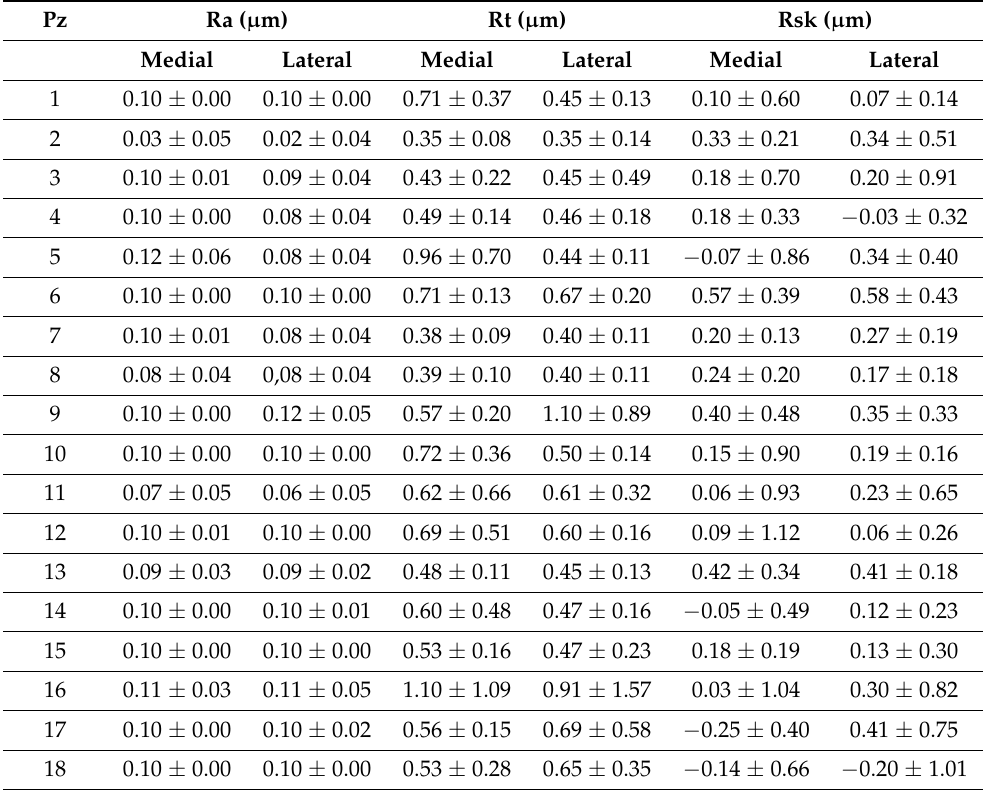
Table 2. Roughness measurements on the femoral knee retrieved